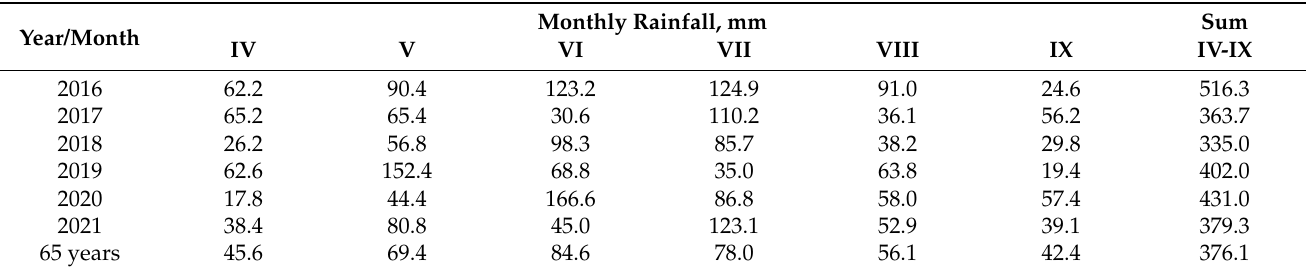
Table 2. The rainfall regime during April–September, 2016–2021, at